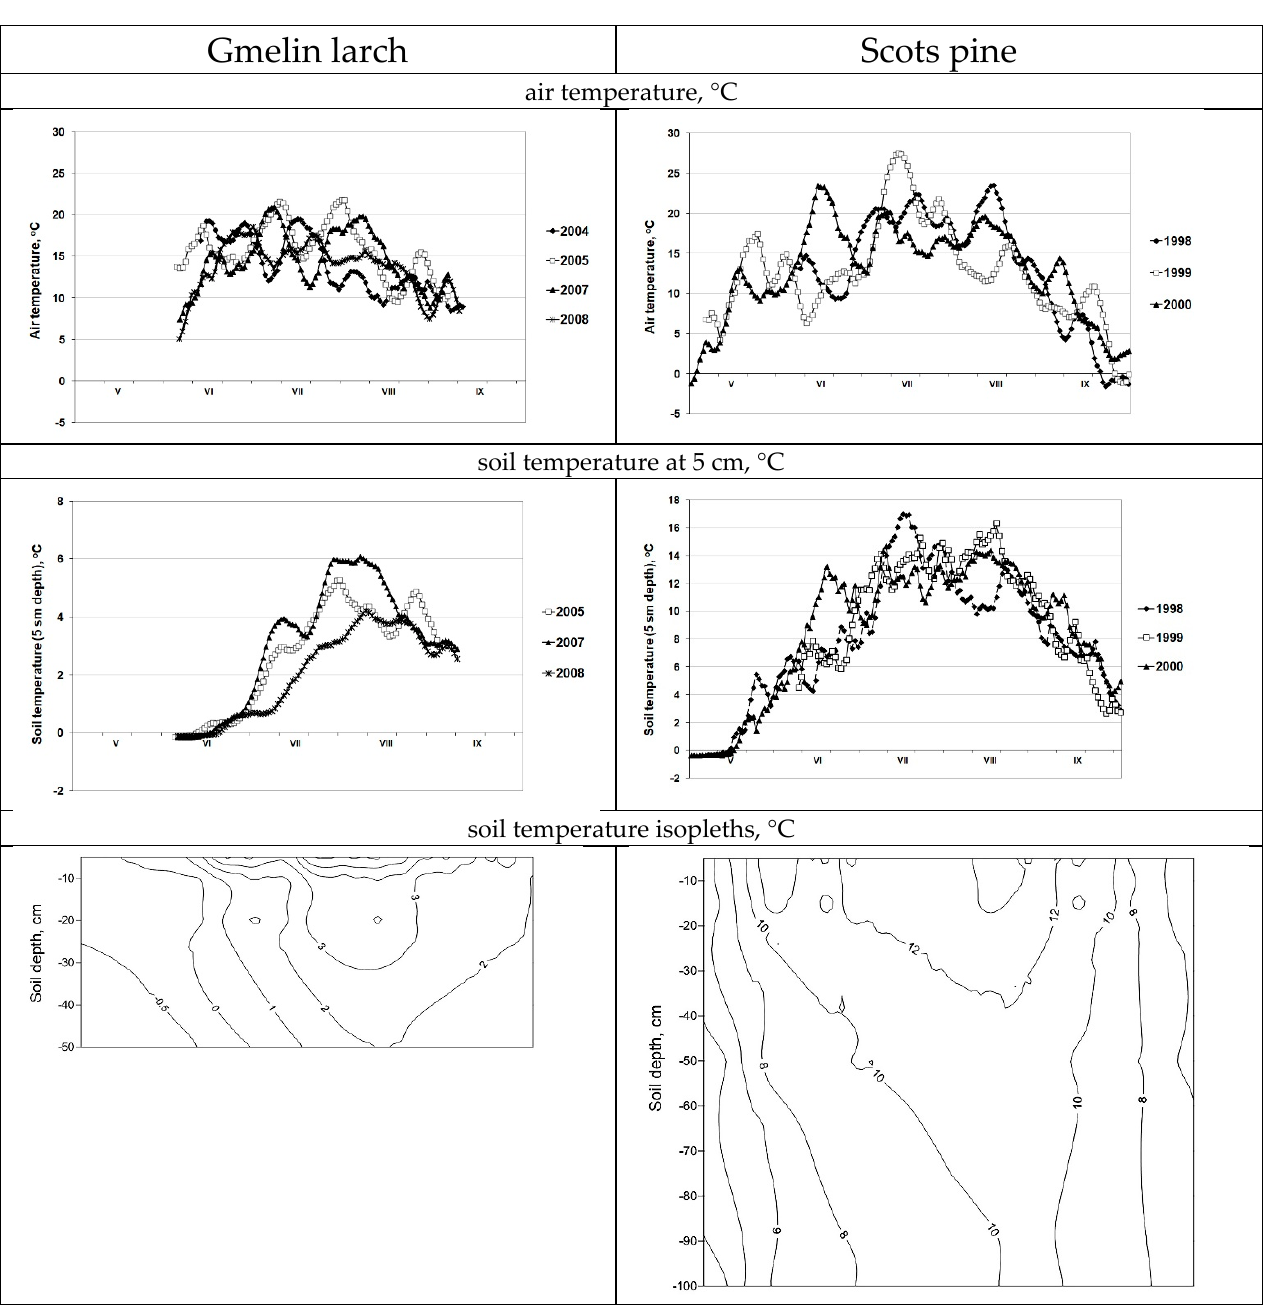
Figure 3. Temperature of the air ( upper ) and soils at 5 cm ( middle ) and soil temperature isopleths at various depths ( lower ) for one season in the Gmelin larch ( left ) and Scots pine ( right ) ecosystems for the growing season.